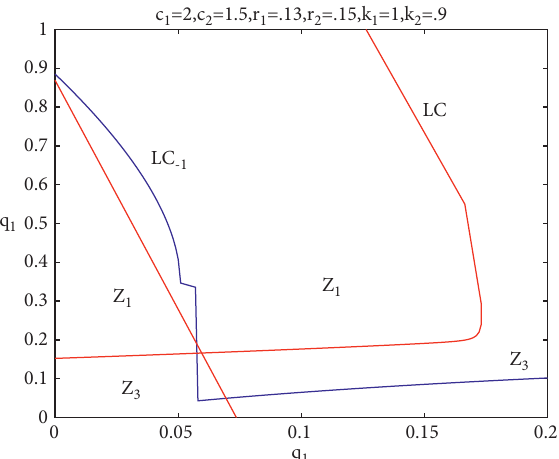
Figure 5: The critical curves LC and LC at the set of parameters: c � 1 , k � 0 . 9. k 1 2